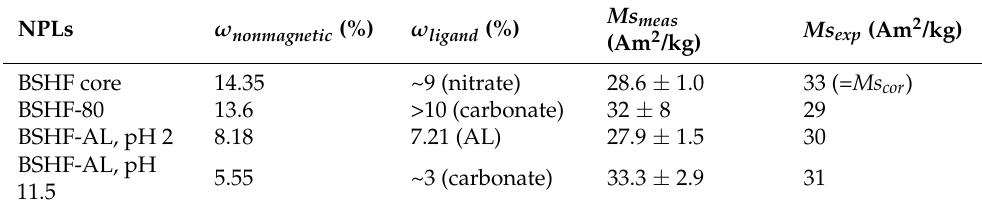
Table 3. Room temperature Ms values of the selected NPLs, all washed with water. The measured Ms values are given with the error estimated from the mass-measurement uncertainty of ± 0.1 mg. The Ms values of the core BSHF NPLs were corrected for the mass fraction of adsorbed water and nitrates, as Ms cor = Ms meas / ( 1 − ω water + nitrate ) . The estimated Ms values of the coated NPLs correspond to (cid:16) (cid:17) Ms exp = Ms cor × 1 − ω nonmagnetic . NPLs ω nonmagnetic